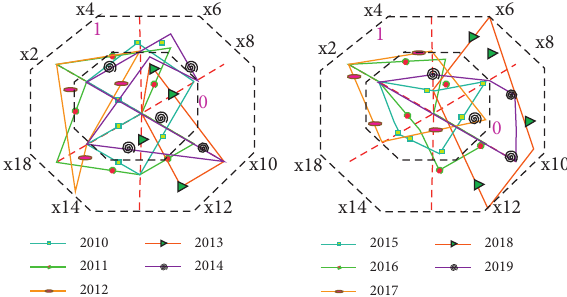
Figure 5: Comprehensive evaluation of pollutant emission status.